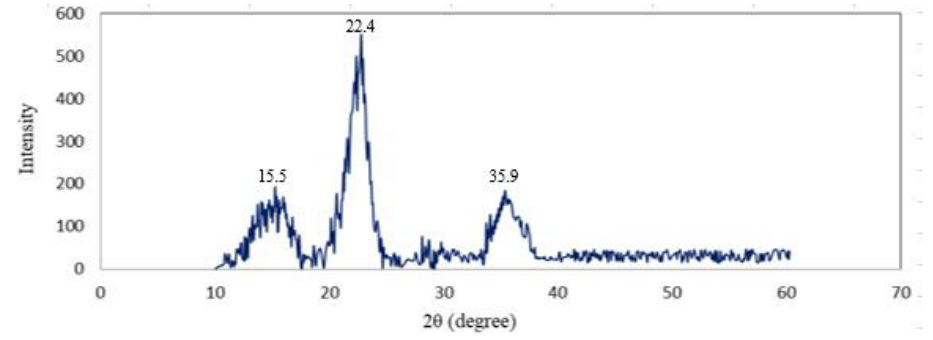
Figure 8. X-ray diffractogram of the CNC.